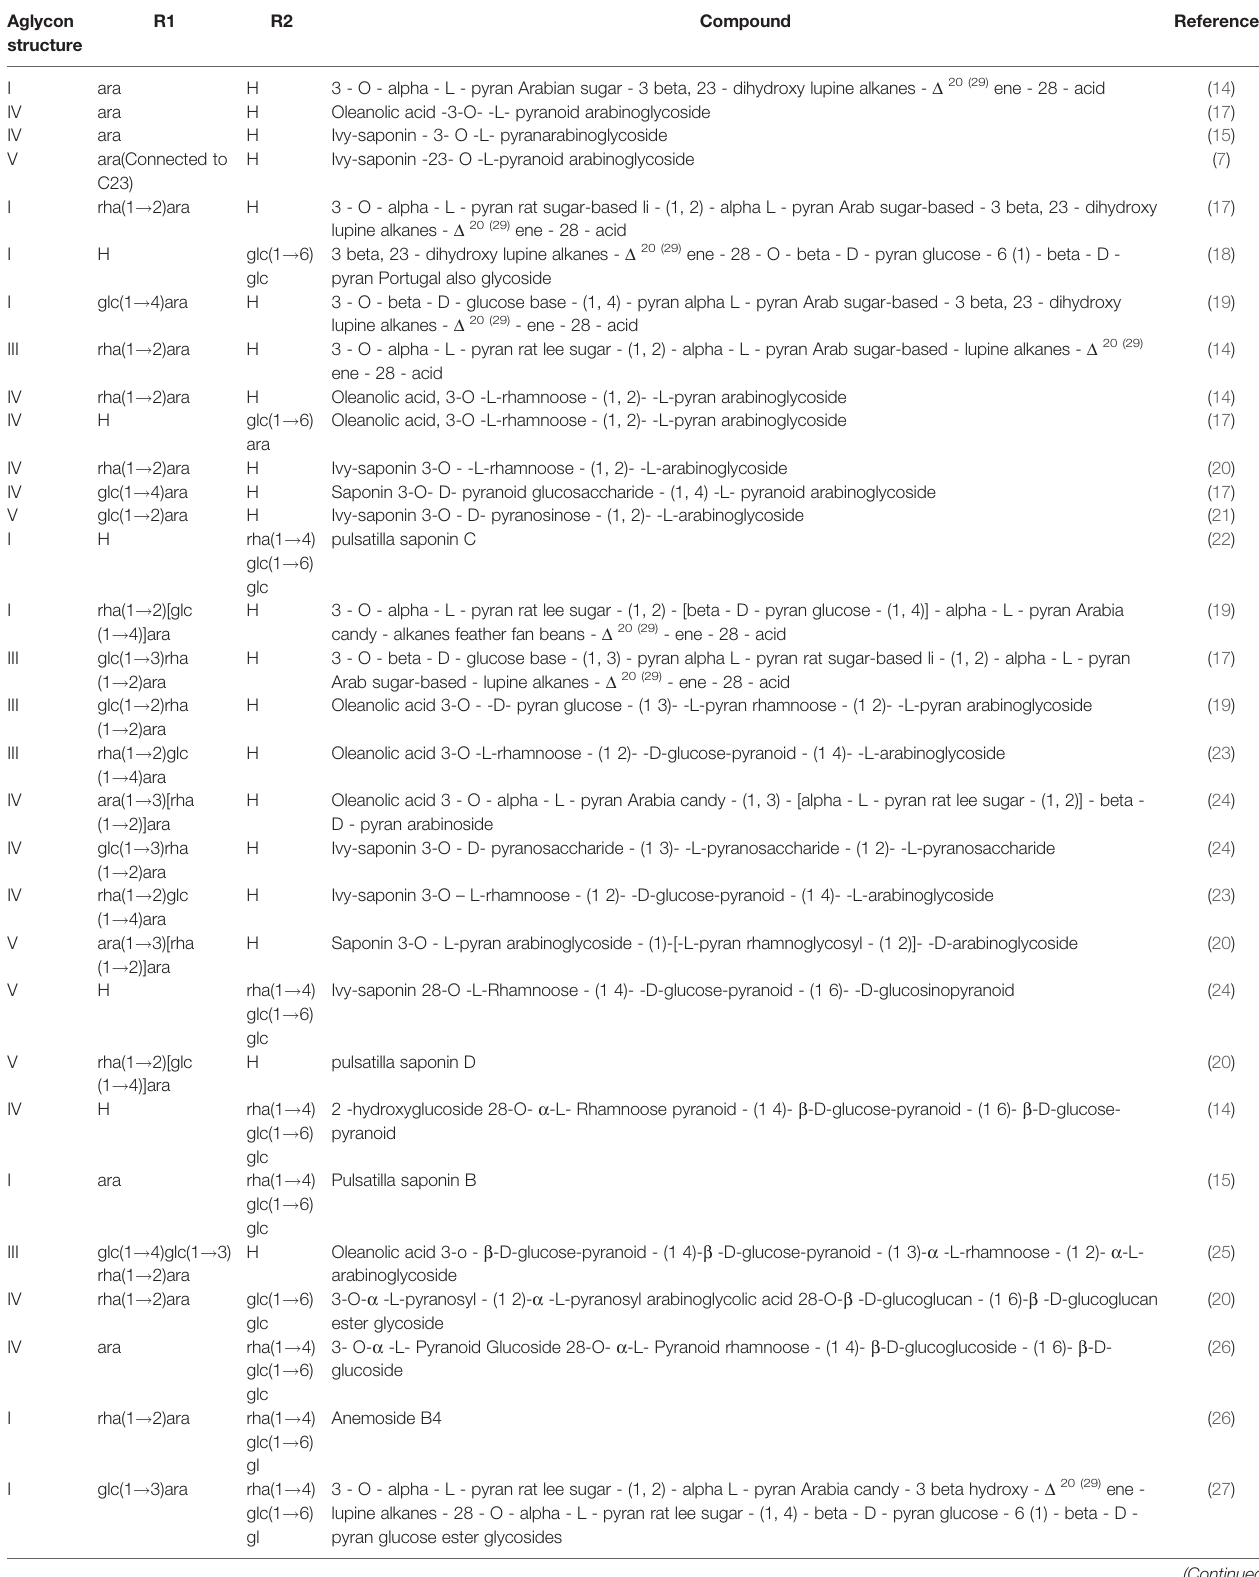
TABLE 1 | Types of saponins in Pulsatilla chinensis (Bge.) Regel. Aglycon structure